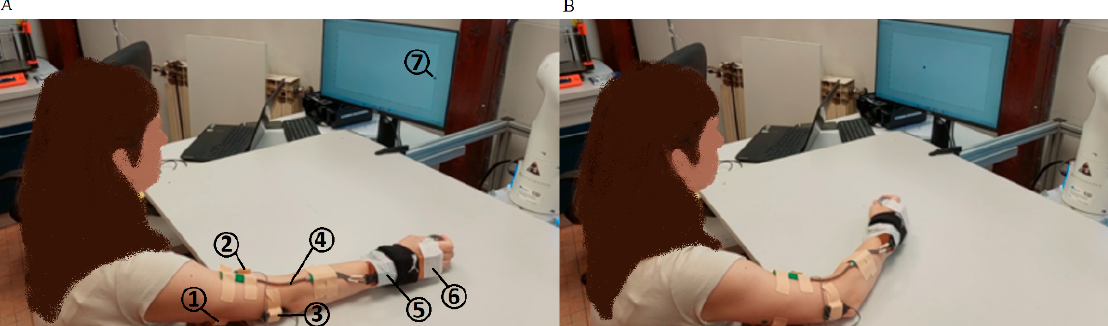
Figure 1. Experimental setup: ( A ) initial position of the arm; ( B ) the position of the arm during the motion. 1—EMG electrodes located on triceps brachii long head muscle, 2—EMG electrodes located on biceps brachii long head muscle, 3 and 5—IMU units, 4—goniometer, 6—wrist fixation, 7—feedback display of the movement tempo.